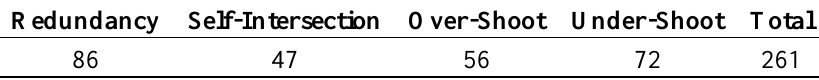
Table 2. Number of topologic errors in the city Wuhan OSM roads.